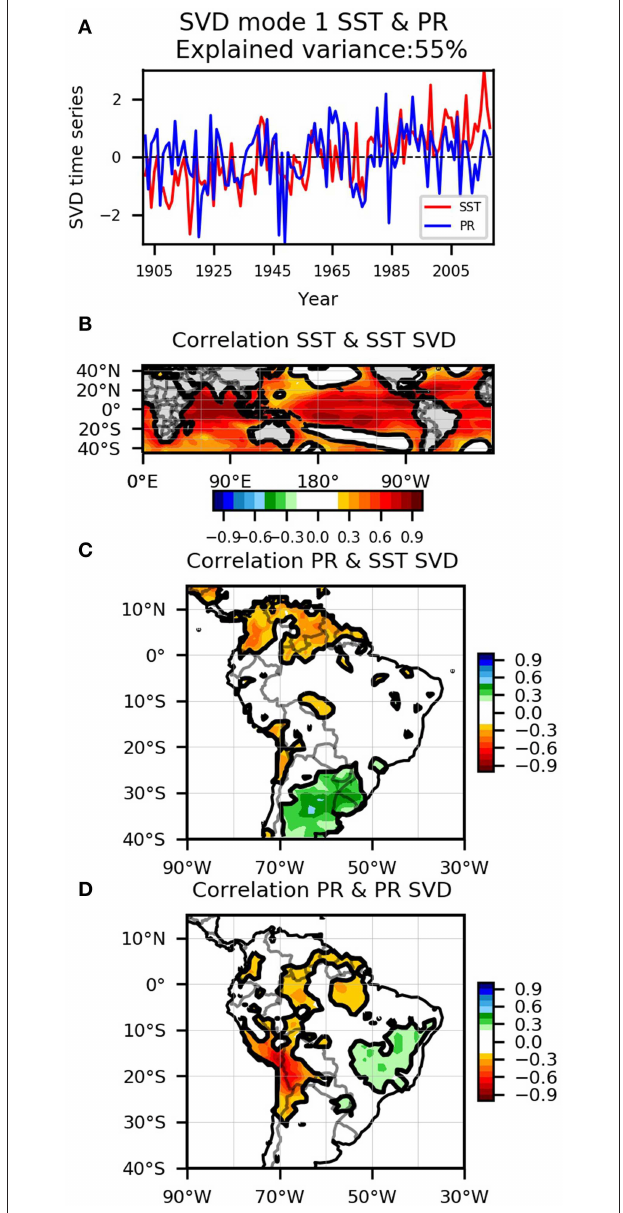
FIGURE 4 | (A) SVD time series of SST (blue) and rainfall anomalies (red) over Altiplano from reanalysis datasets for the period 1902–2018. (B) Homogeneous correlation map between the SVD time series of SST and SST anomalies. (C) Heterogeneous correlation map between the SVD time series of SST and rainfall anomalies. (D) Homogeneous correlation map between the SVD time series of rainfall and rainfall anomalies. Contours indicate 95% significance